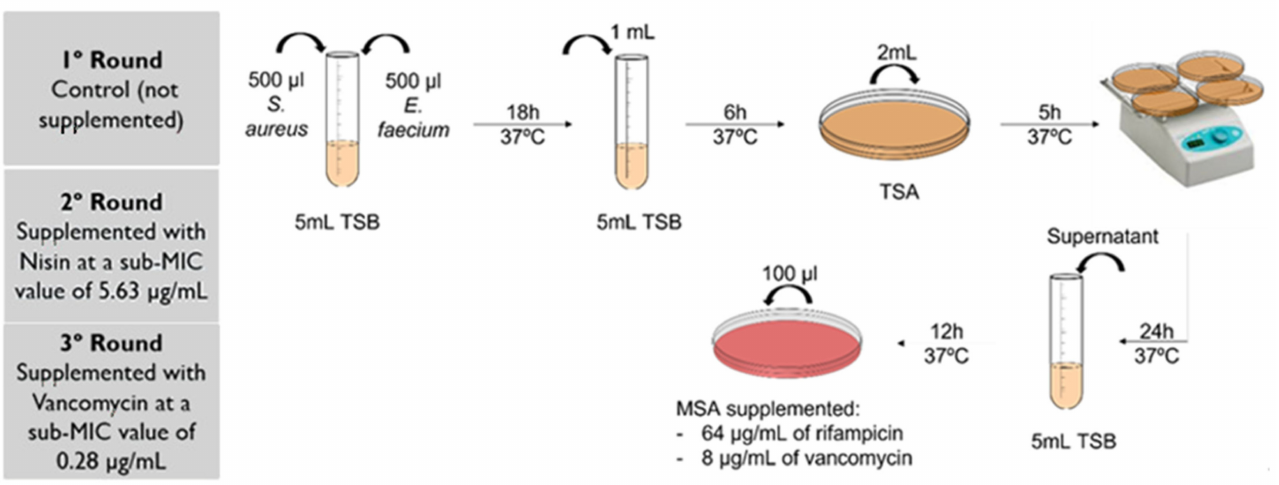
Figure 4. Schematic representation of the adapted horizontal gene transfer protocol. TSB—tryptic soy broth; TSA—tryptic soy agar; MSA—mannitol salt